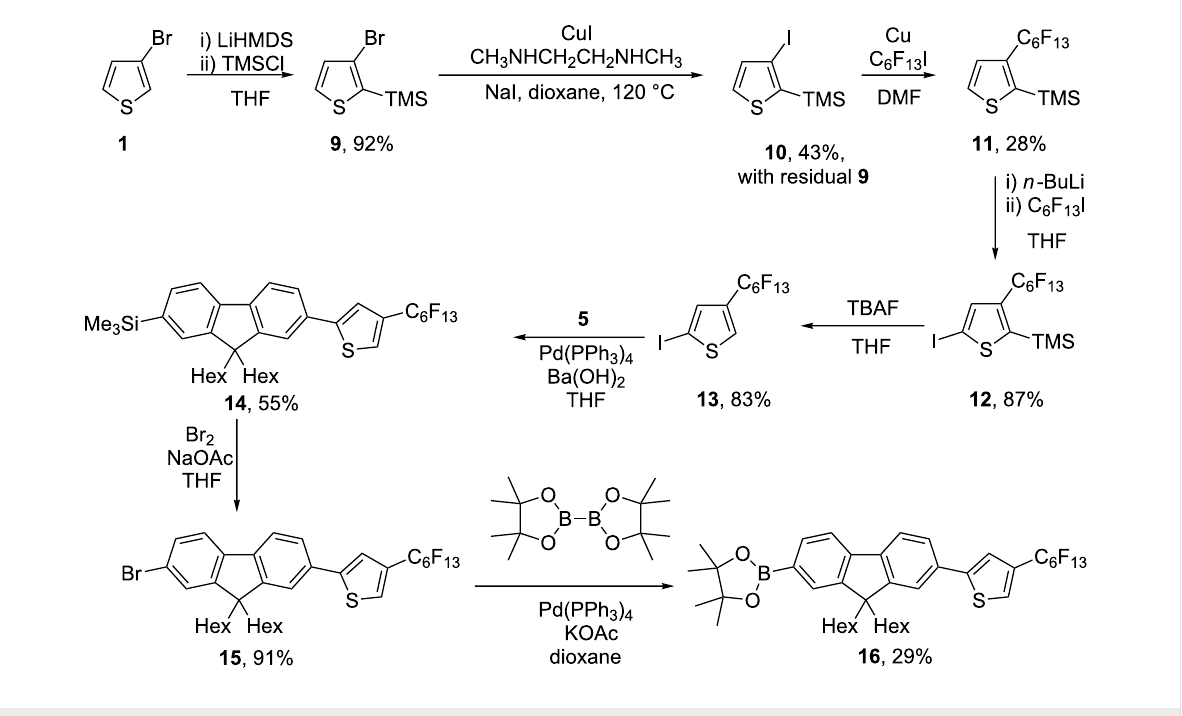
Scheme 2: Synthesis of the thiophene-fluorene arm for the